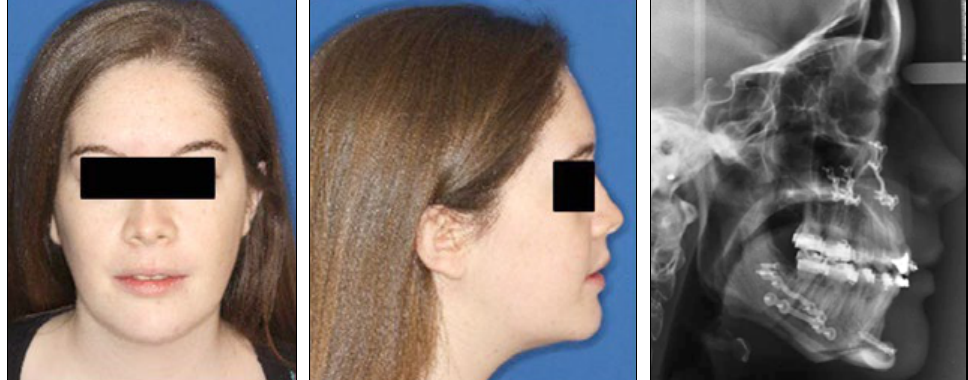
Figure 6. Post-surgical photographs and cephalogram of a patient treated by anti-clockwise rotation of the occlusal